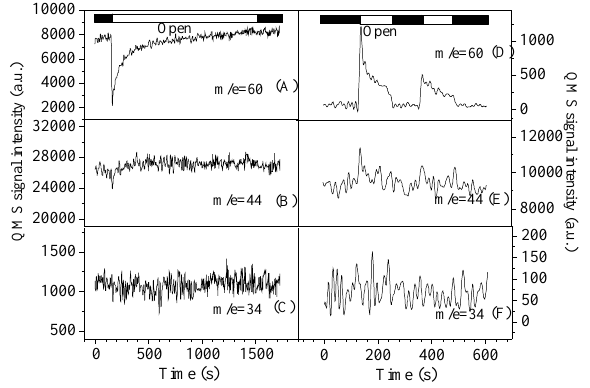
Fig. 2. The heterogeneous reaction of OCS on 141.3 mg of α -Fe 2 O 3 at 300 K (left side) and the in situ desorption of surface species in the end of uptake (right side).